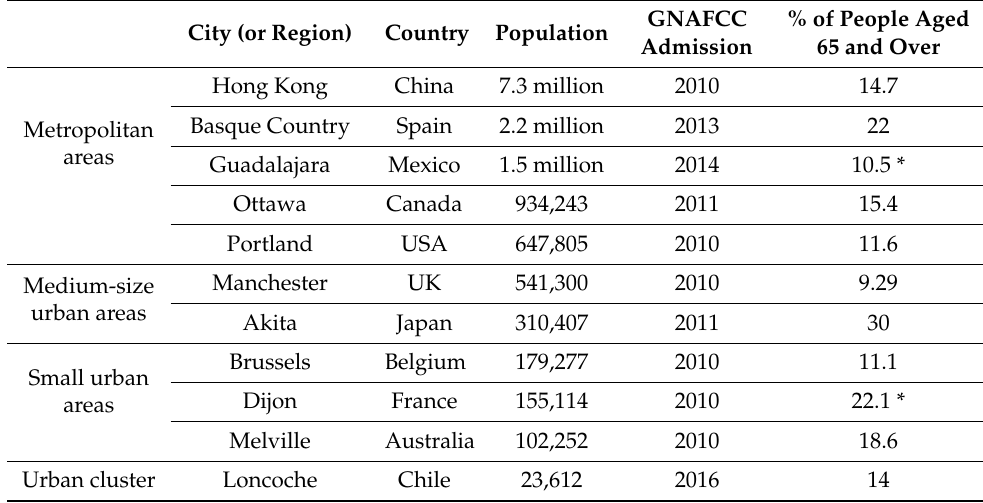
Table 1. Key characteristics of the eleven